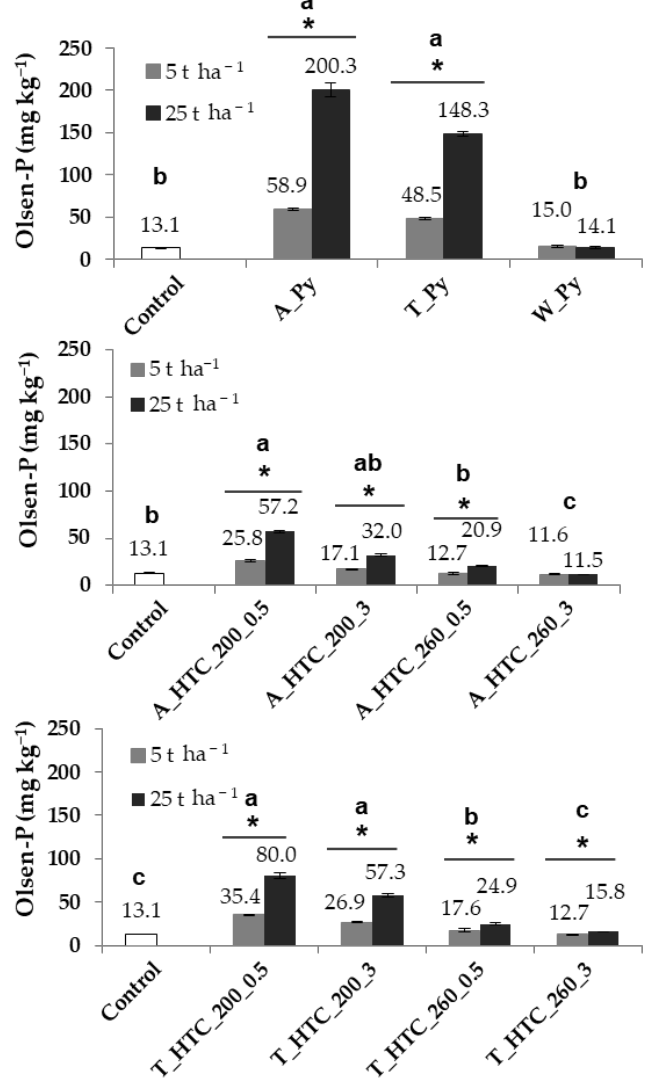
Figure 2. P extracted by the Olsen method (Olsen-P) in the control (soil without amendment but with plant growth) and hydrochar- and pyrochar-amended pots at 5 and 25 t ha −1 at the end of the greenhouse experiment. The hydrochars were produced from primary (A) and secondary sludge (T) at 200 °C and 260 °C for 0.5 h and 3 h (A_HTC 200_0.5/3, A_HTC 260_0.5/3; S_HTC 200_0.5/3, T_HTC 260_0.5/3). The pyrochars A_Py, T_Py were obtained from primary and secondary sludge and W_Py from green waste. The letters show significant differences between treatments. The above-line asterisks indicate significant differences between doses. Error bars represent the standard deviation of the mean ( n = 4)